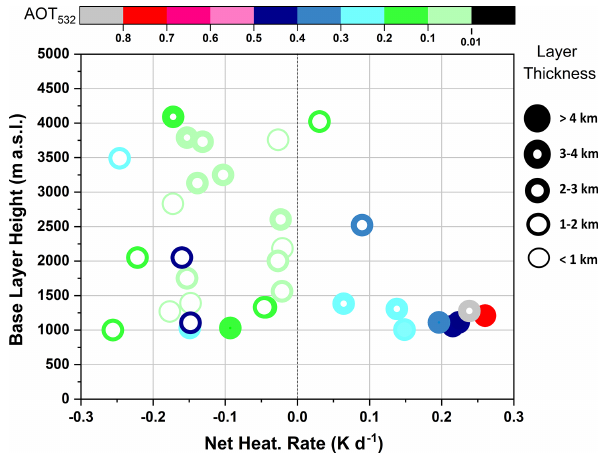
Figure 8. Net heating rate values per case of Scheme C estimated at BOA, 25 ◦ SZA versus base layer height. The horizontal color bar indicates the AOT 532 values, and the vertical symbol thickness indicates the layer